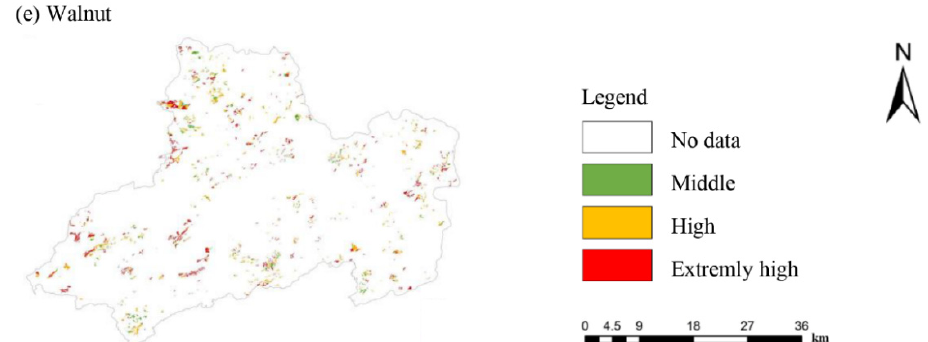
Figure 11. Spatial distribution map of landslide susceptibility of dominant tree species in Zhijin County.